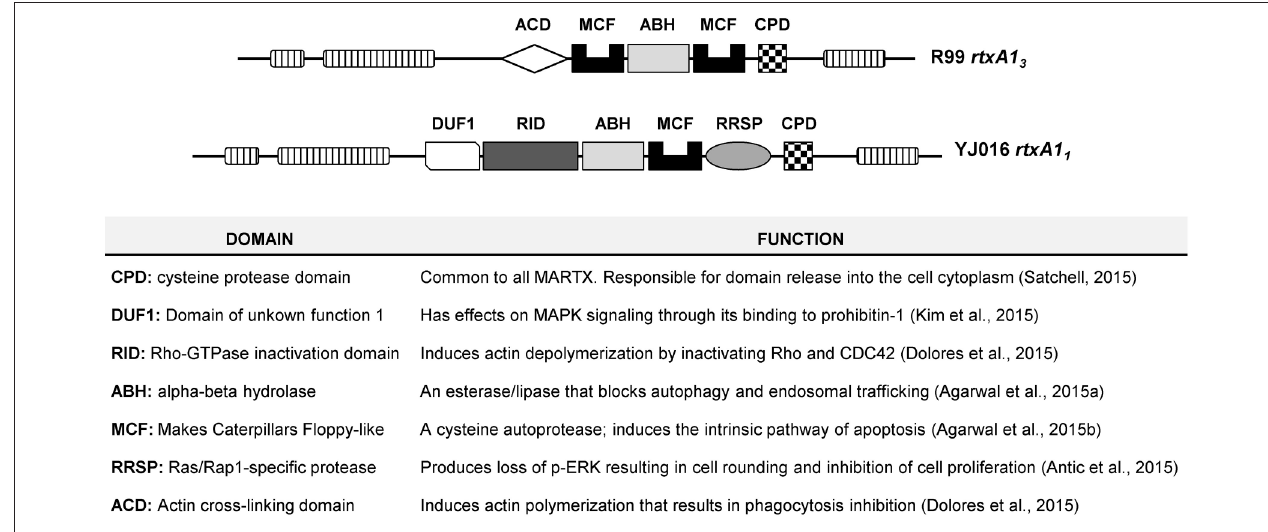
FIGURE 1 | Schematic representation of type III and type I MARTX toxins, and function of each domain.